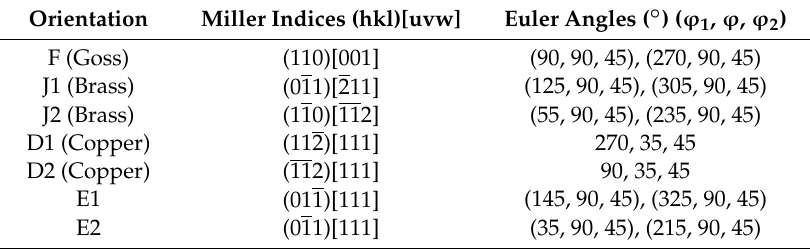
Table 3. Ideal deformation shear texture components of BCC metals and alloys expressed in the rolling reference system with hkl || ND and uvw || RD and their FCC rolling system equivalents in